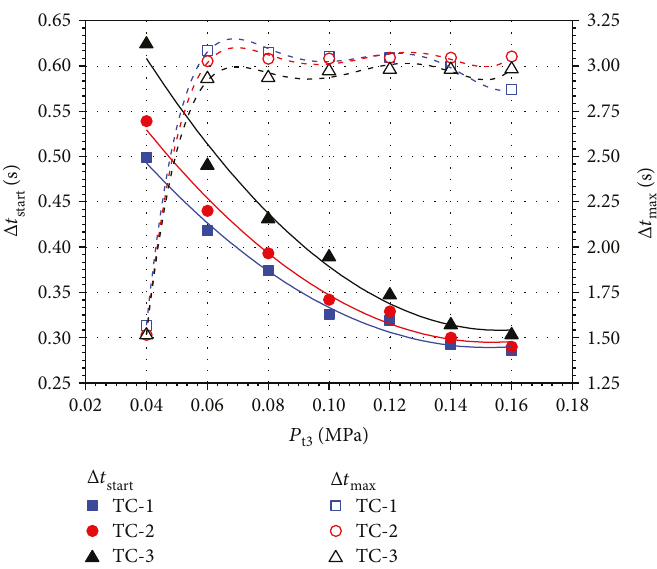
Figure 7: E ff ect of inlet pressure on the time of temperature rise at the combustion chamber exit.